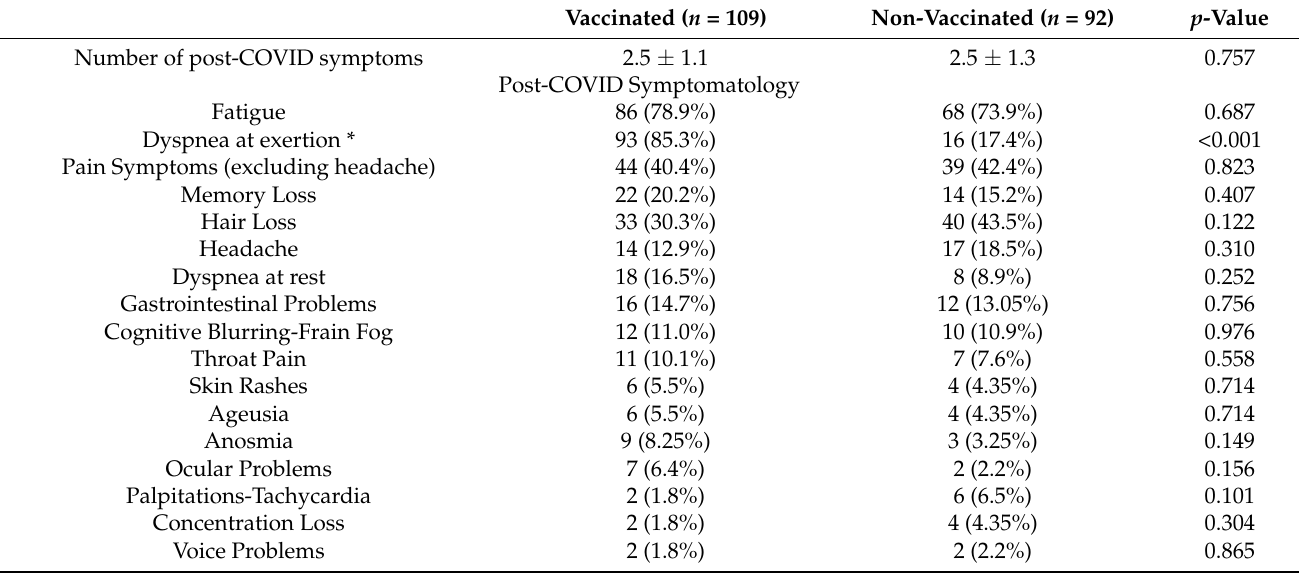
Table 2. Post-COVID Symptoms and Psychological Symptoms according to Vaccine